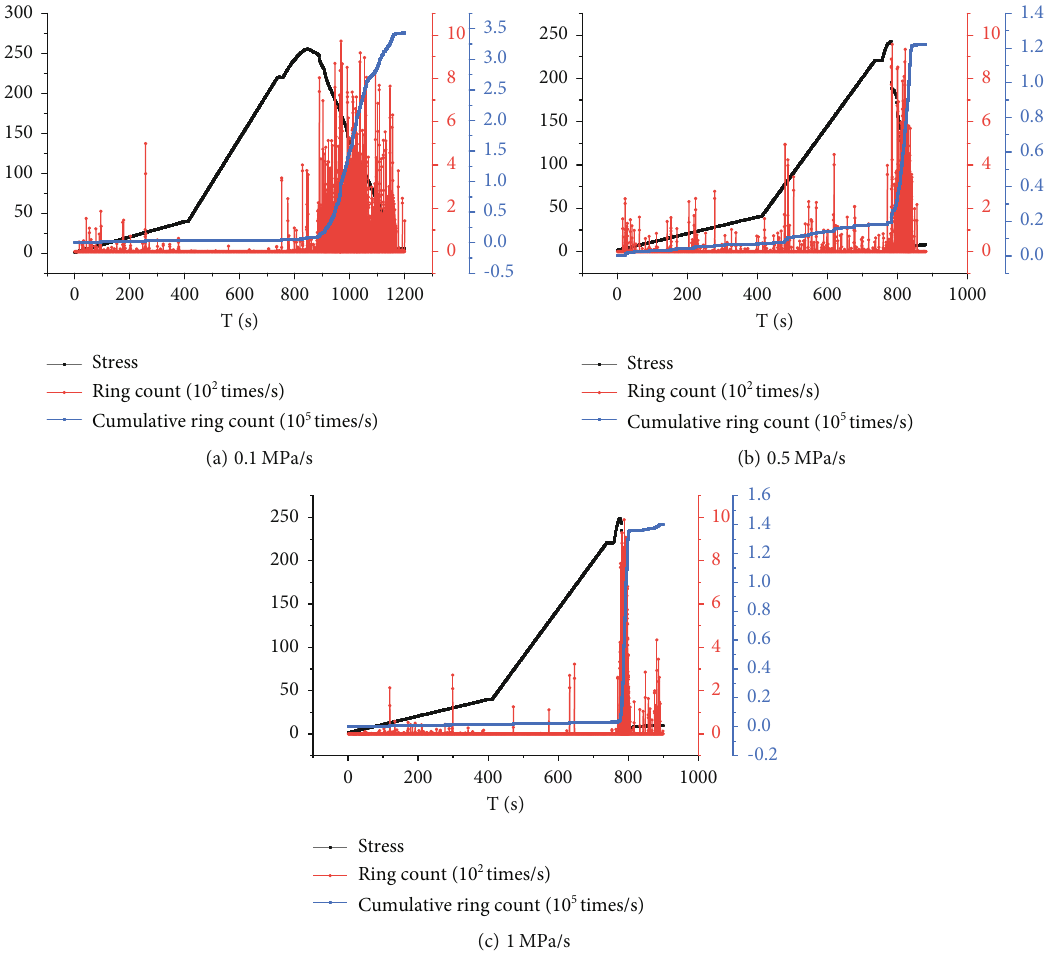
Figure 4: Limestone stress-(cumulative) acoustic emission energy-time relationship curve at the same con fi ning pressure with di ff erent unloading rates. Note: in the fi gure, the black vertical coordinate on the left side represents the stress magnitude during the loading of the limestone, the red vertical coordinate on the right side represents the acoustic emission ringing counts during the loading of the limestone, and the blue coordinate represents the cumulative ringing